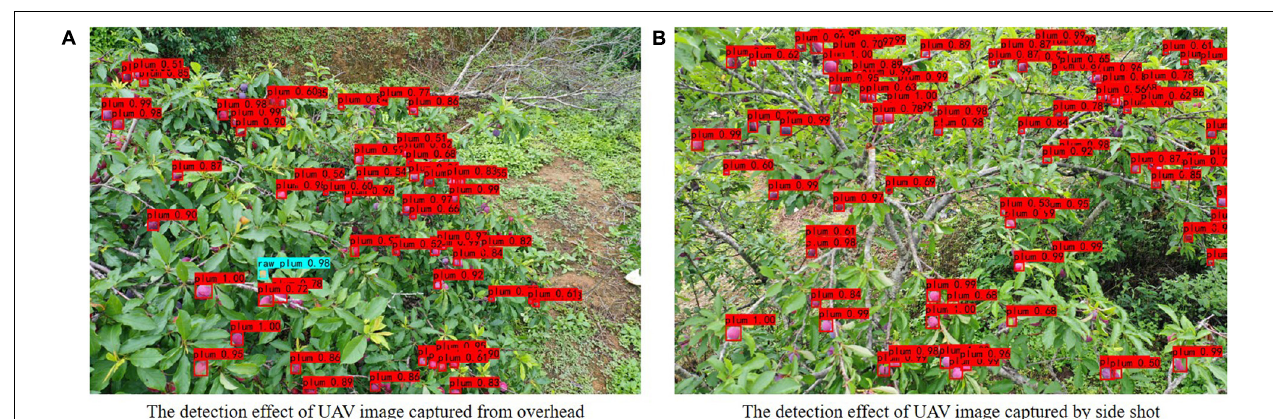
FIGURE 8 | Plum detection effect pictures under different dense conditions.